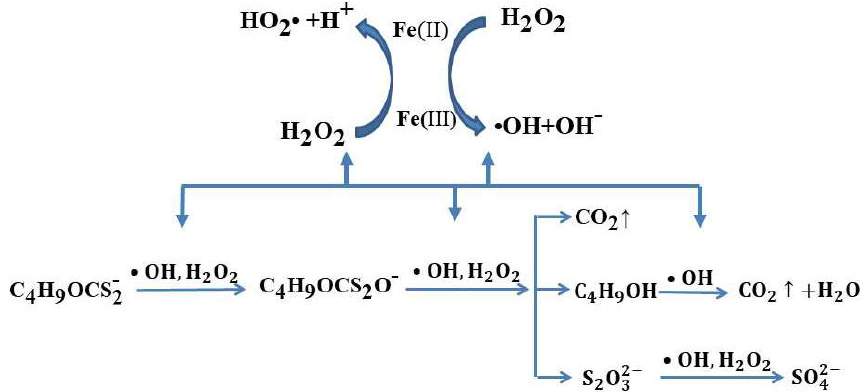
Figure 2. Production of hydroxyl radicals and degradation pathway of butyl xanthate (reproduced from Environ. Sci. Pollut. Res. Int. 2016, 23, 15202−15207 with permission from Elsevier) [55].